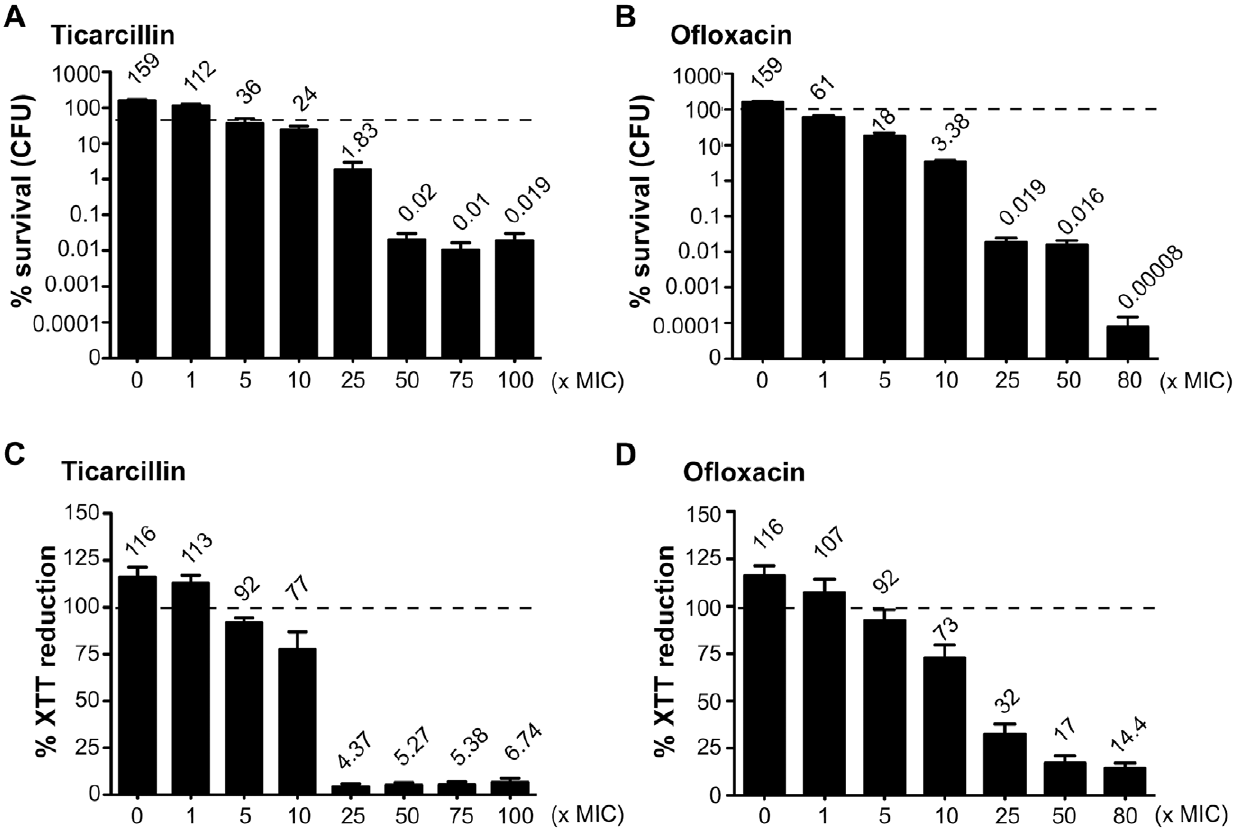
Figure 1. Antibiotic-tolerant populations of E.coli K-12 TG1 biofilms. Twenty-four-hour biofilms of E. coli TG1 were preformed in M63B1 Gluc and treated for a period of 24 h with concentrations up to 100- and 80-times the MIC values for ticarcillin and ofloxacin, respectively. Untreated controls represent 48 h biofilms in which fresh M63B1 Gluc without antibiotic was added after 24 h, explaining their values above 100%, represented by a dotted line in each panel. Viable cells of the treated biofilm population were quantified by viable cell counts (A and B) and the XTT-reduction assay (C and D) and were compared to numbers obtained prior to antibiotic treatment. % survival (CFU) values are indicated on top of each bar and are means 6 standard error of the means (SEM) of at least six replicates.